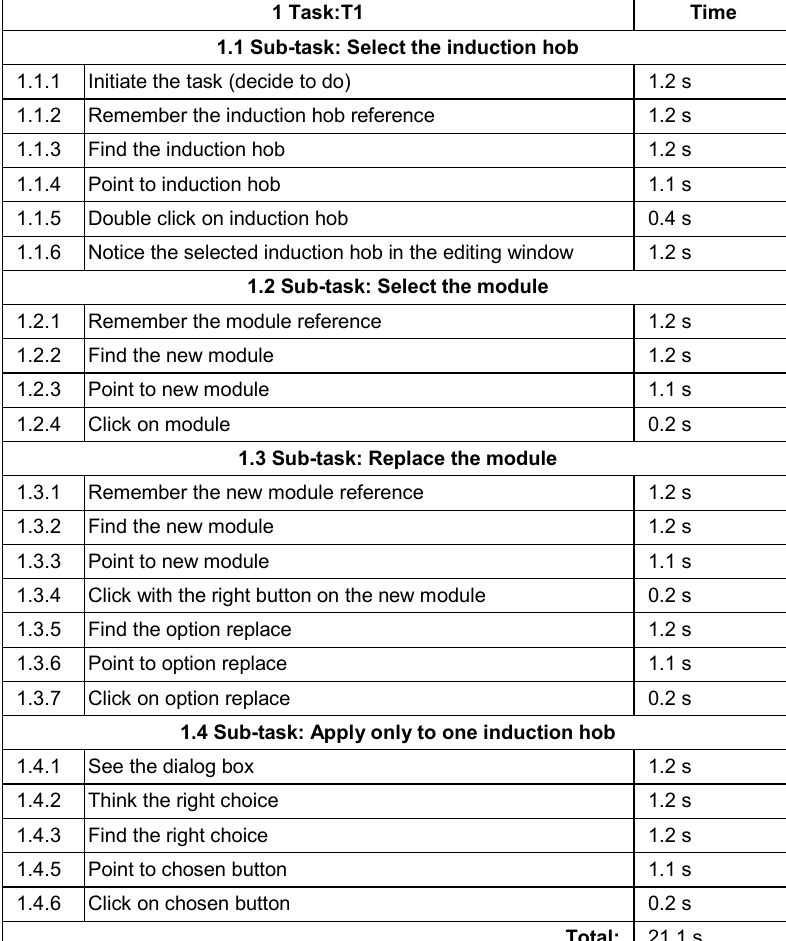
Table 1. Detailed time prediction for task